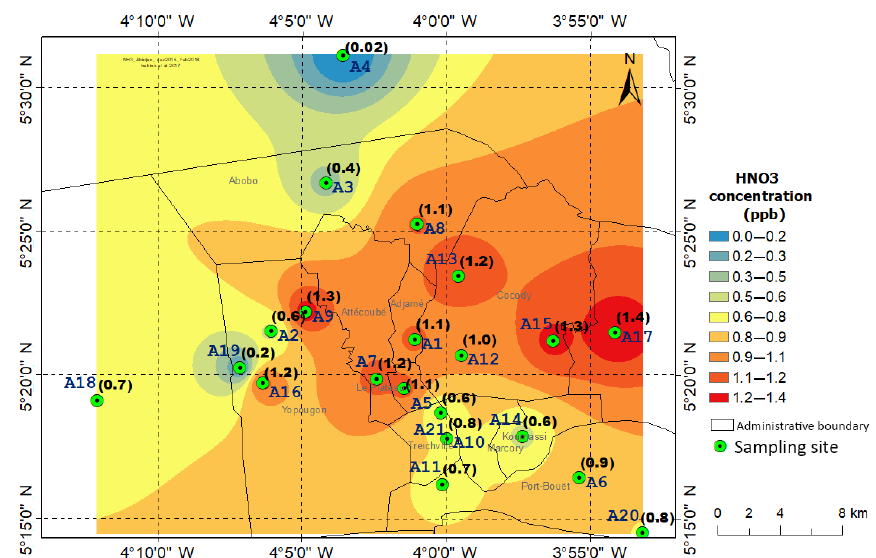
Figure 10. Spatial distribution of HNO 3 in the district of Abidjan during the dry season (15 December 2015–16 February 2016). Measured concentrations inppb are in